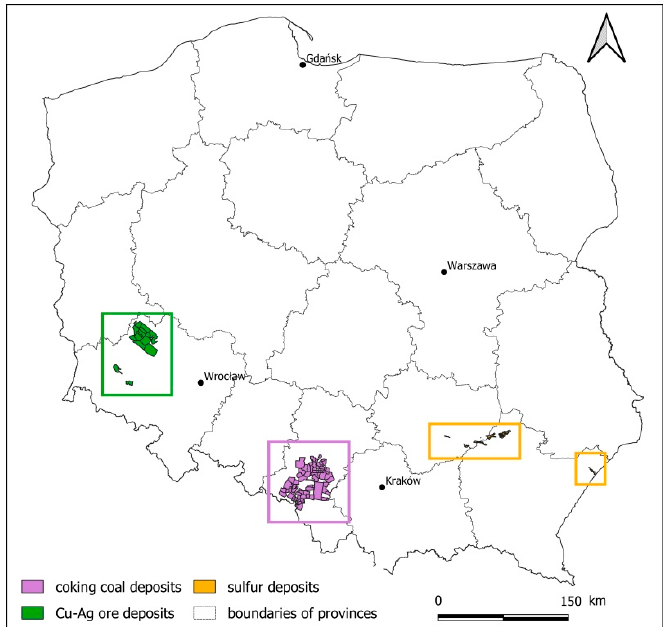
Figure 1. Overall location of mineral deposits for the production of analyzed mineral raw materials (based on [15]).